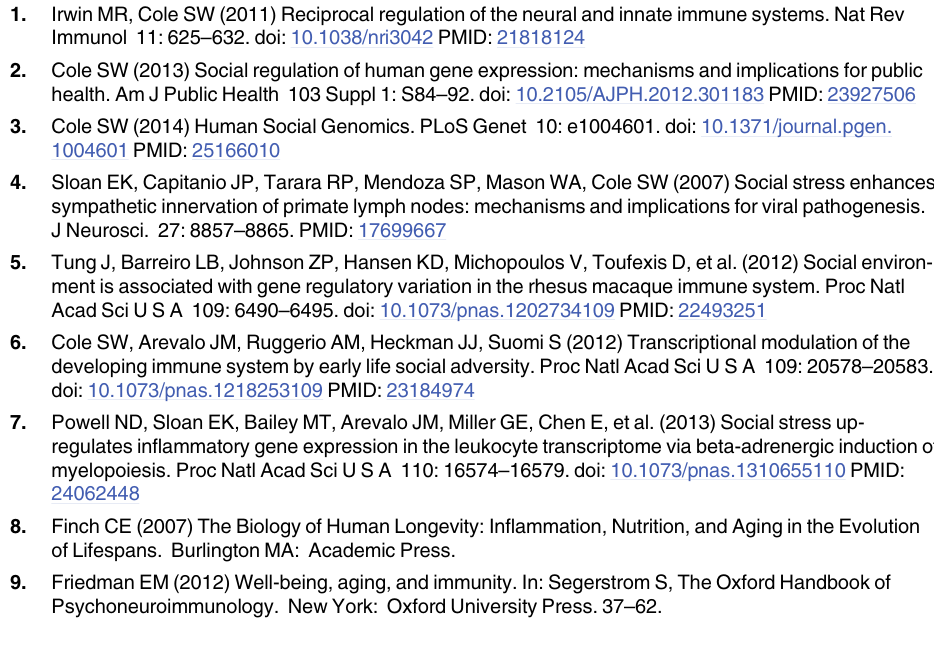
S2 Table. Confirmation study association of well-being with gene expression controlling for depressive symptoms. S3 Table. Confirmation study association of well-being with gene expression: unstructured covariance matrix. S4 Table. Association of alternative MHC-SF well-being measures with gene expression. S5 Table. Confirmation study association of well-being with gene expression: Including im- puted IL6